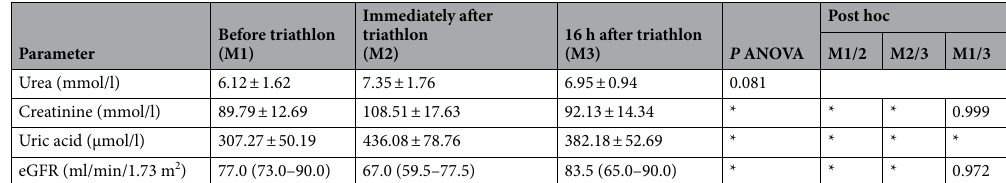
Table 6. Mean values (± SD) of electrolyte concentrations in the 3 performed measurements (M). *Significant difference ( P < 0.05).